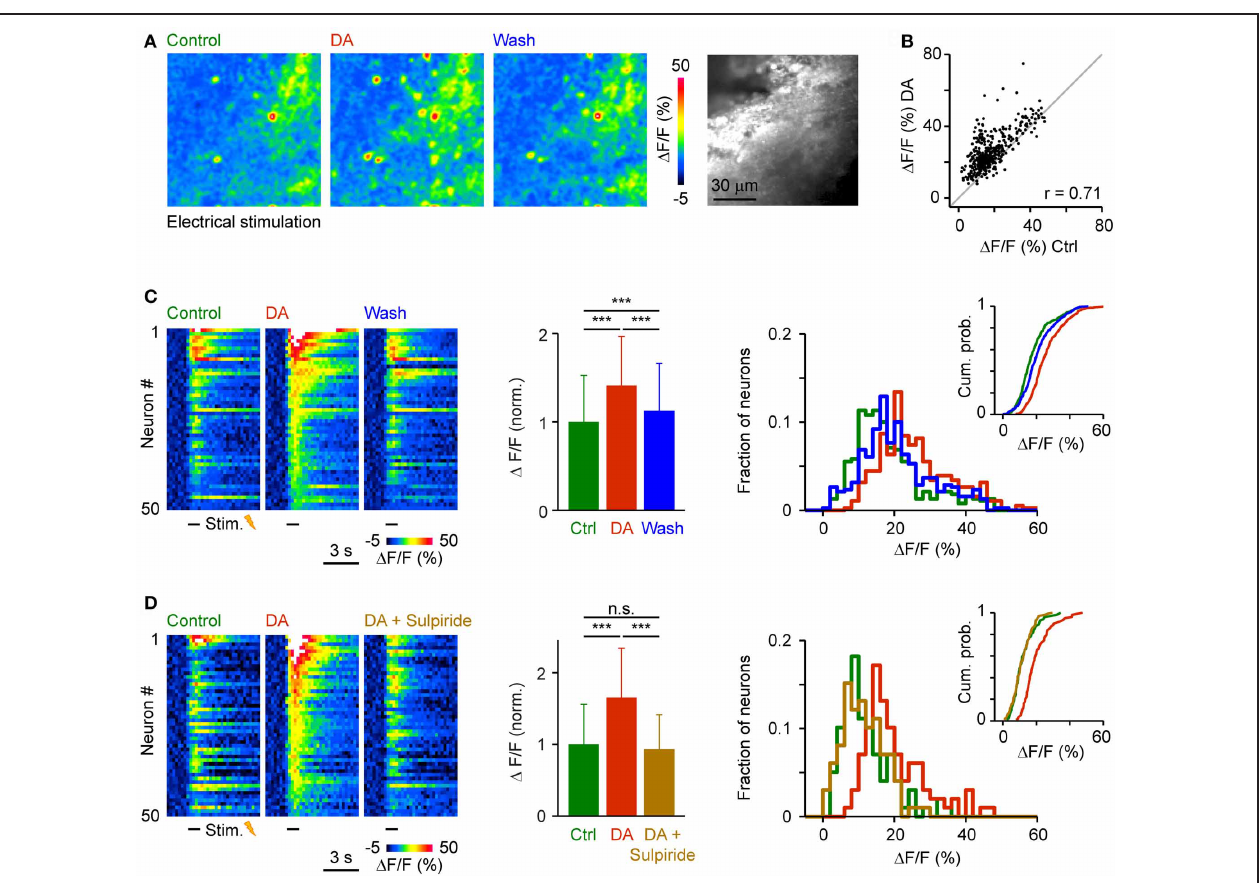
presence of DA. Center: Mean amplitude of calcium signals before, during and after exposure to DA ( n = 380 from 3 fish; normalized). Right: Distribution of response amplitudes before, during and after DA exposure. Inset shows cumulative probability distribution. (D) Calcium signals of 50 randomly selected neurons (left), mean calcium signals of all neurons ( n = 99 from 2 fish; center), and amplitude distributions (right) before DA, during the presence of DA, and after addition of sulpiride (50 µ M). ∗∗∗ P < 0 . 001; n.s., not significant.